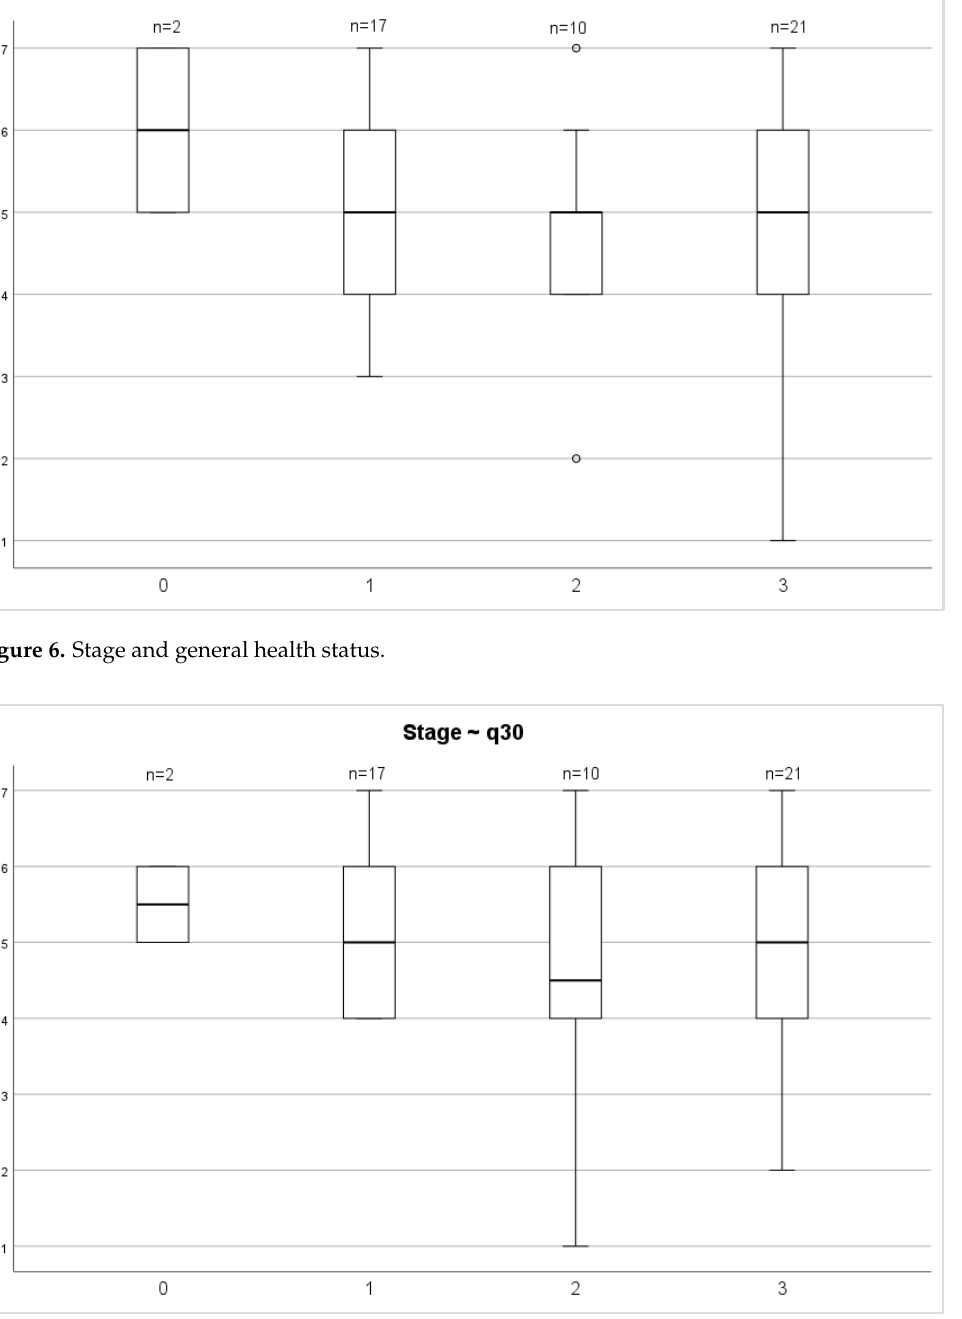
Figure 7. Stage and overall quality of life. Forty-six (52.3%) patients had rectal cancer. This localization of tumors is associated with worse overall health status and overall QoL scores (Figures 8 and 9). However, no significant differences between these groups were found ( p = 0.2035; p =